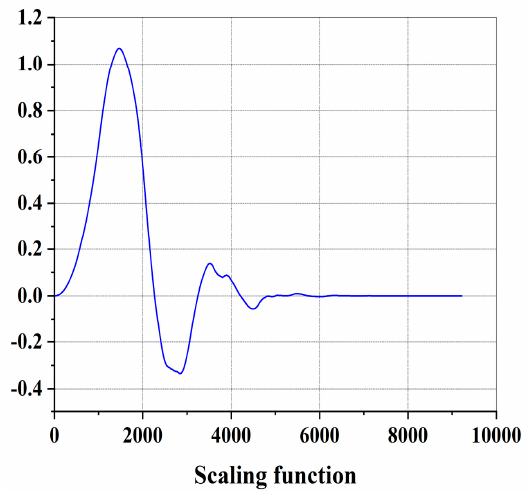
Figure 6. Scaling Figure 6. Scaling function.